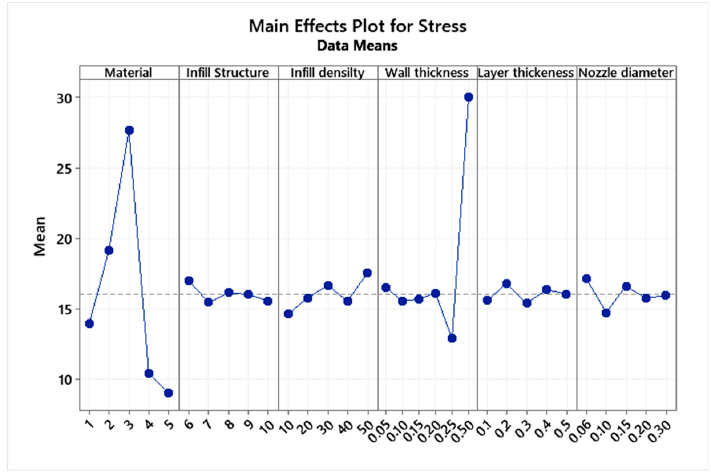
Figure 7. Main effects plot for equivalent stress .